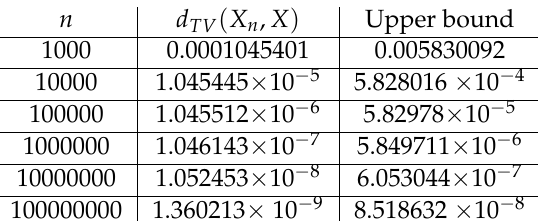
Table 4. Numerical results for a = 1.5 and c =